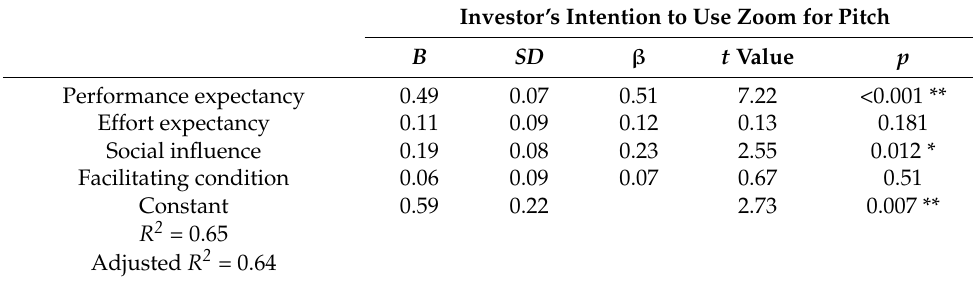
Table 3. Multiple Linear Regression Coefficients associated with investors’ intention to use Zoom for entrepreneurs’ pitch presentations in voluntary